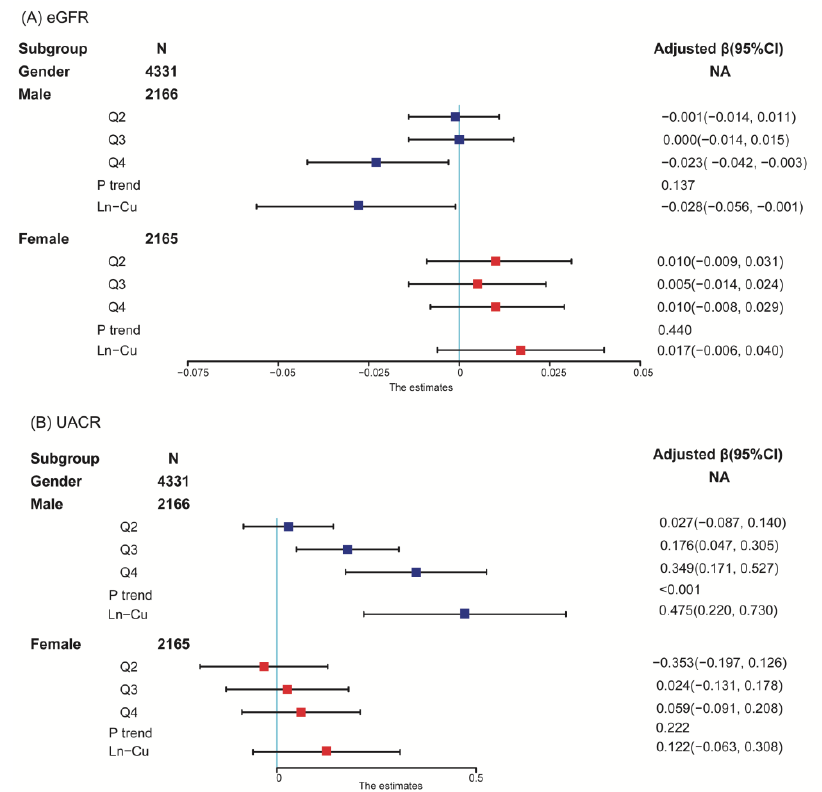
Figure 1. Sex-specific association between serum Cu and kidney function. ( A ) eGFR; ( B ) UACR. Blue and red boxes represent males and females respectively. Models adjusted for age, race, BMI, educational attainment, PIR, alcohol drinking, smoking status, hypertension, and diabetes. The points represent the adjusted β , and the lines represent its 95% confidence interval (95% CI).